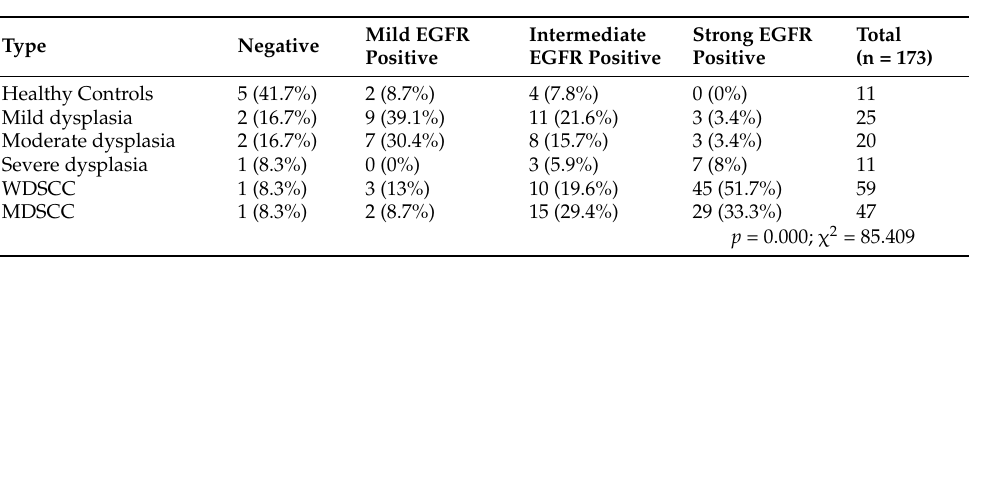
Table 3. Clinical histopathological features in EGFR-positive groups in dysplasia and cancer